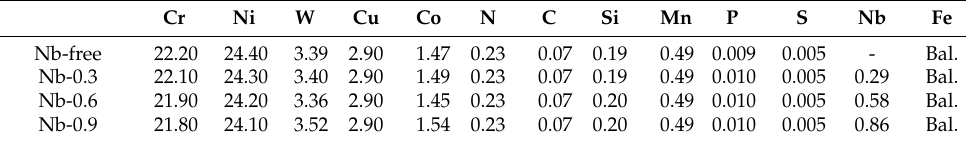
Table 1. Compositions of 22Cr25NiWCuCo(Nb) steel specimens (wt.%).